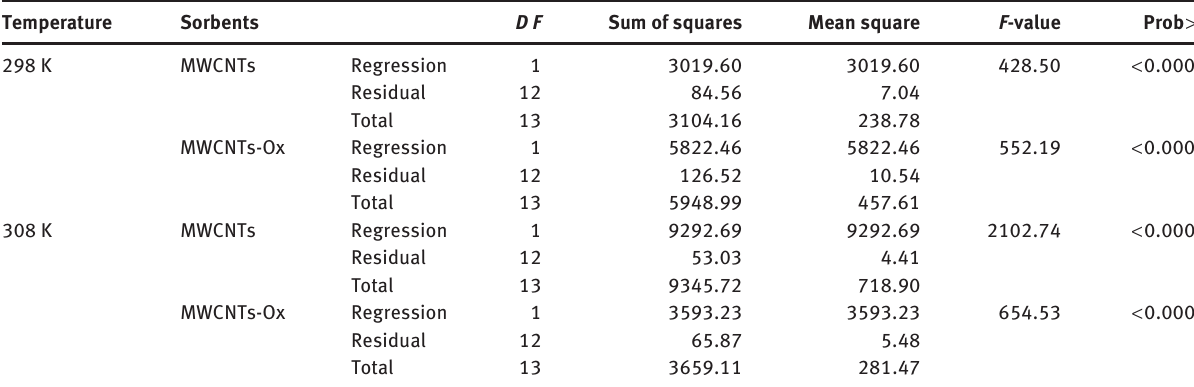
Table 3: Analysis of variance (ANOVA) for adsorption of methylene blue. Temperature